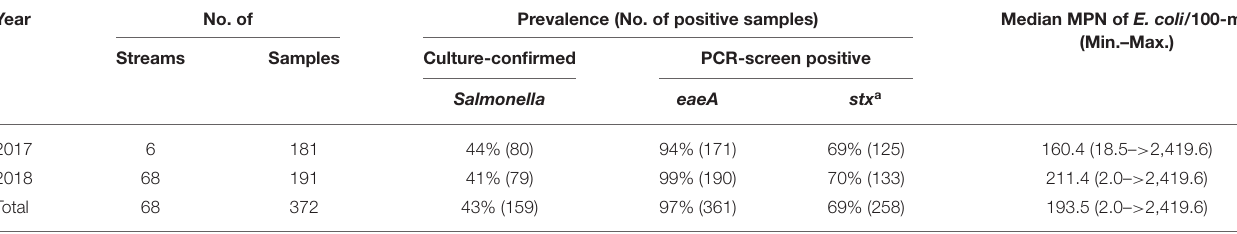
TABLE 1 | Foodborne pathogen prevalence and E. coli levels in New York streams used for produce production. Year No. of Prevalence (No. of positive samples) Median MPN of E. coli /100-mL